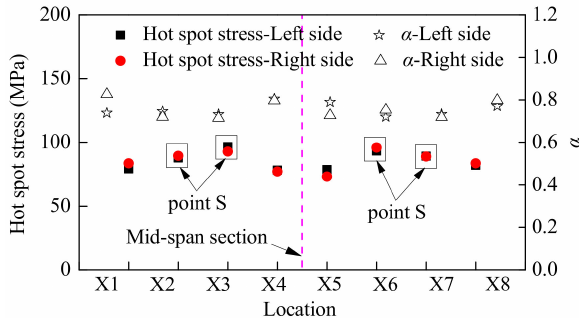
Figure 9. Distribution and comparison of hot-spot stress.